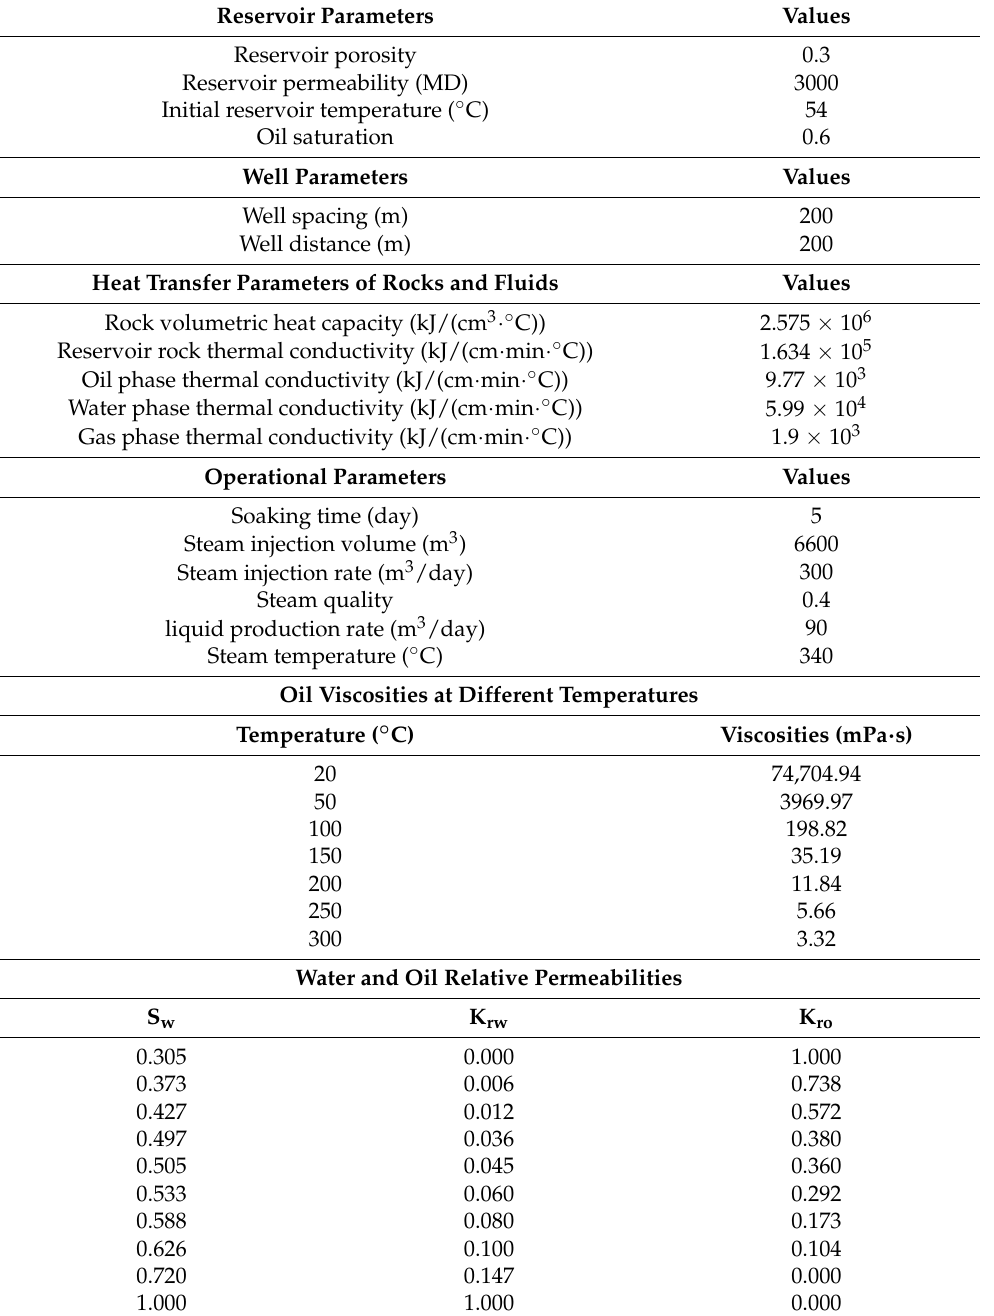
Table 1. The basic parameters used in the CSS simulation